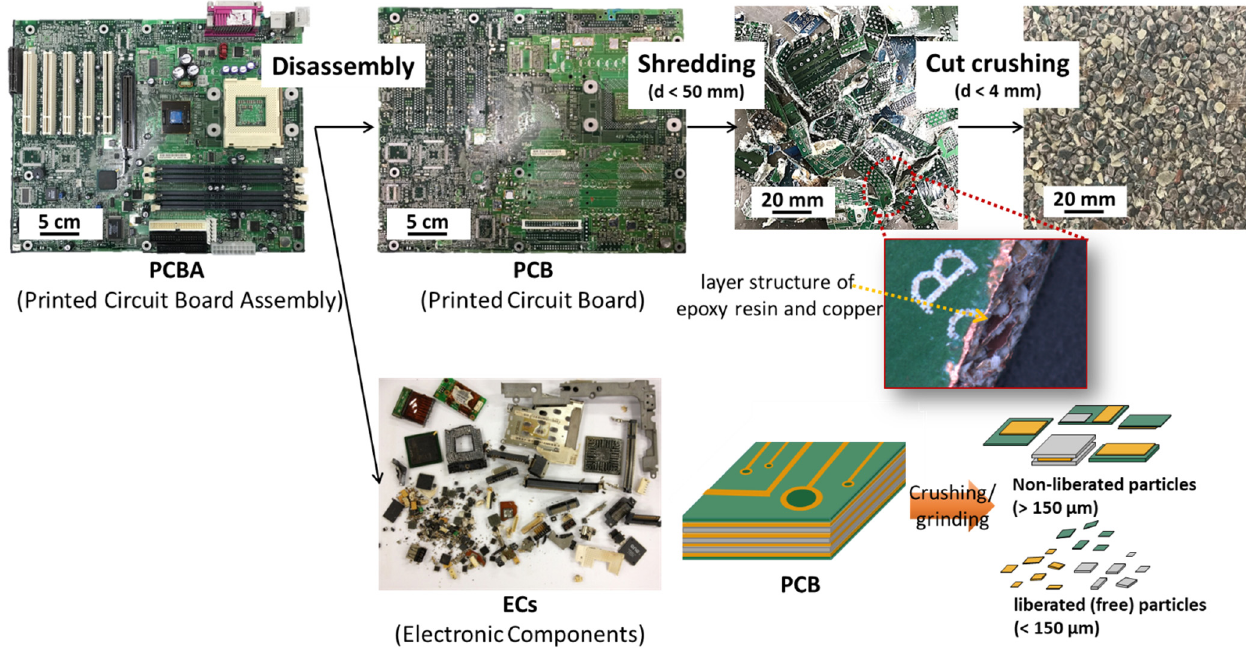
Figure 1. Flowsheet and photo images of PCBA used in this study. PCB and ECs were separated in PCBA, and the ground particles were prepared from PCB by shredding and cut crushing. Schematic of liberation of copper and epoxy resin according to particle size by the typical crushing/grinding method.